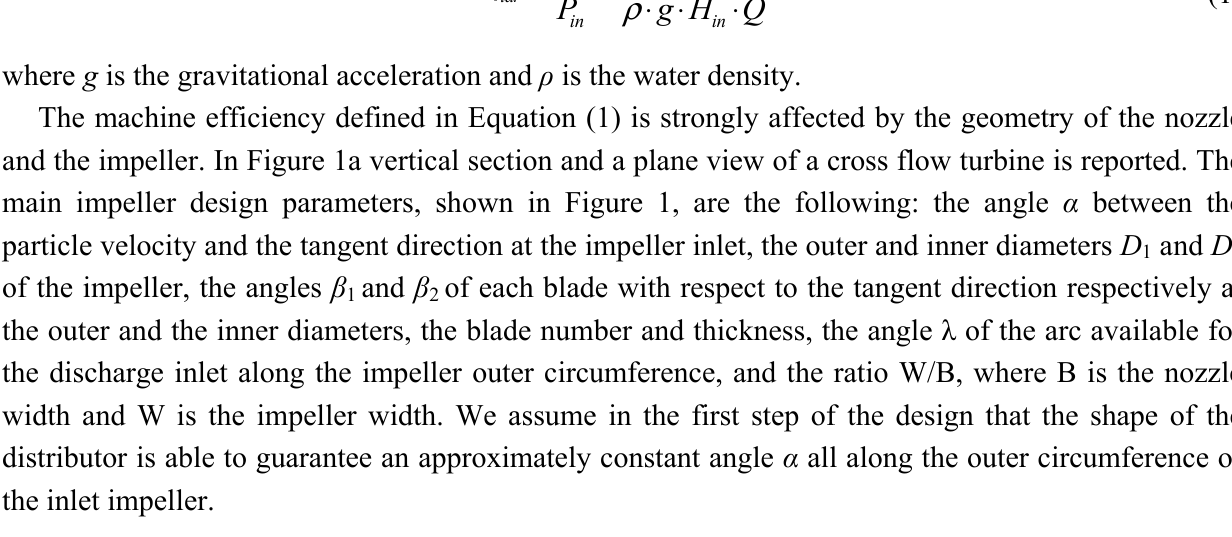
Figure 1. Geometrical parameters of the cross flow